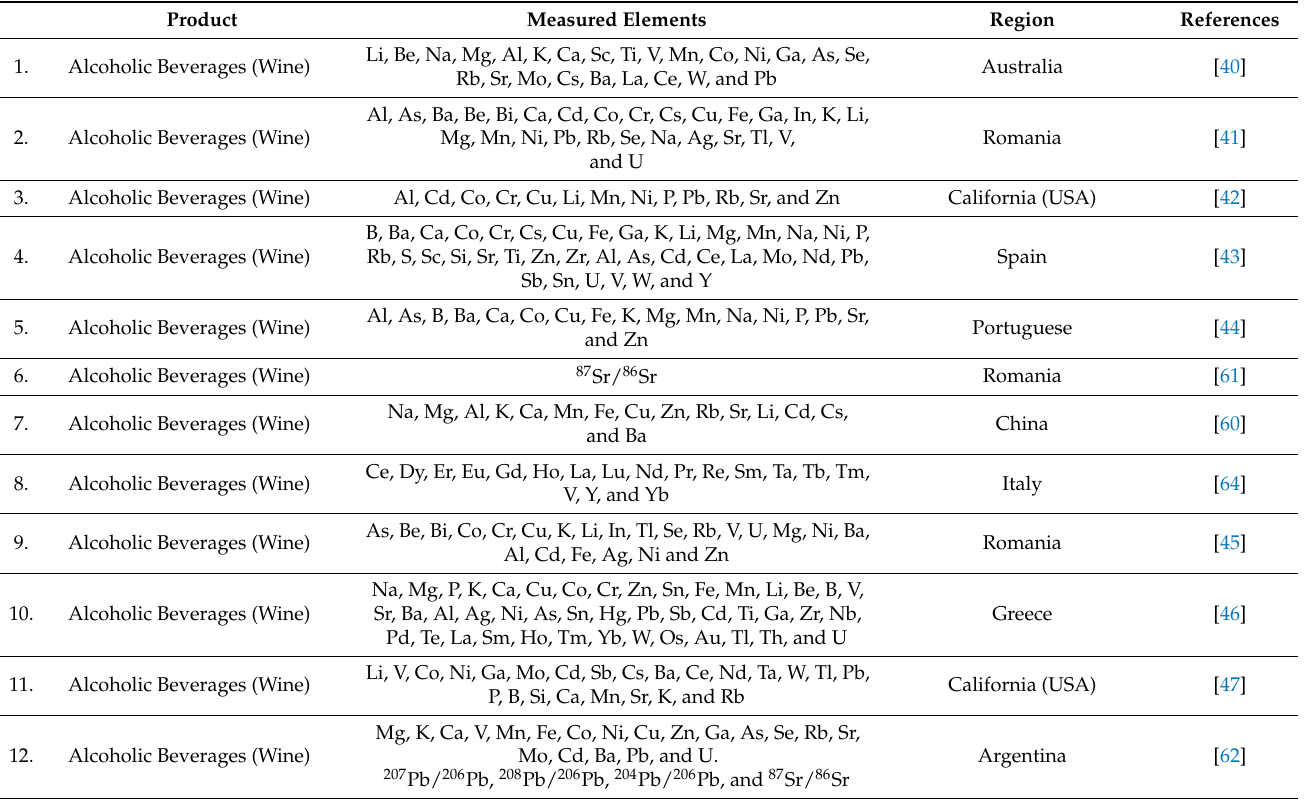
Table 2. Table containing the overview of the literature regarding the authenticity and traceability of agricultural products, foods and